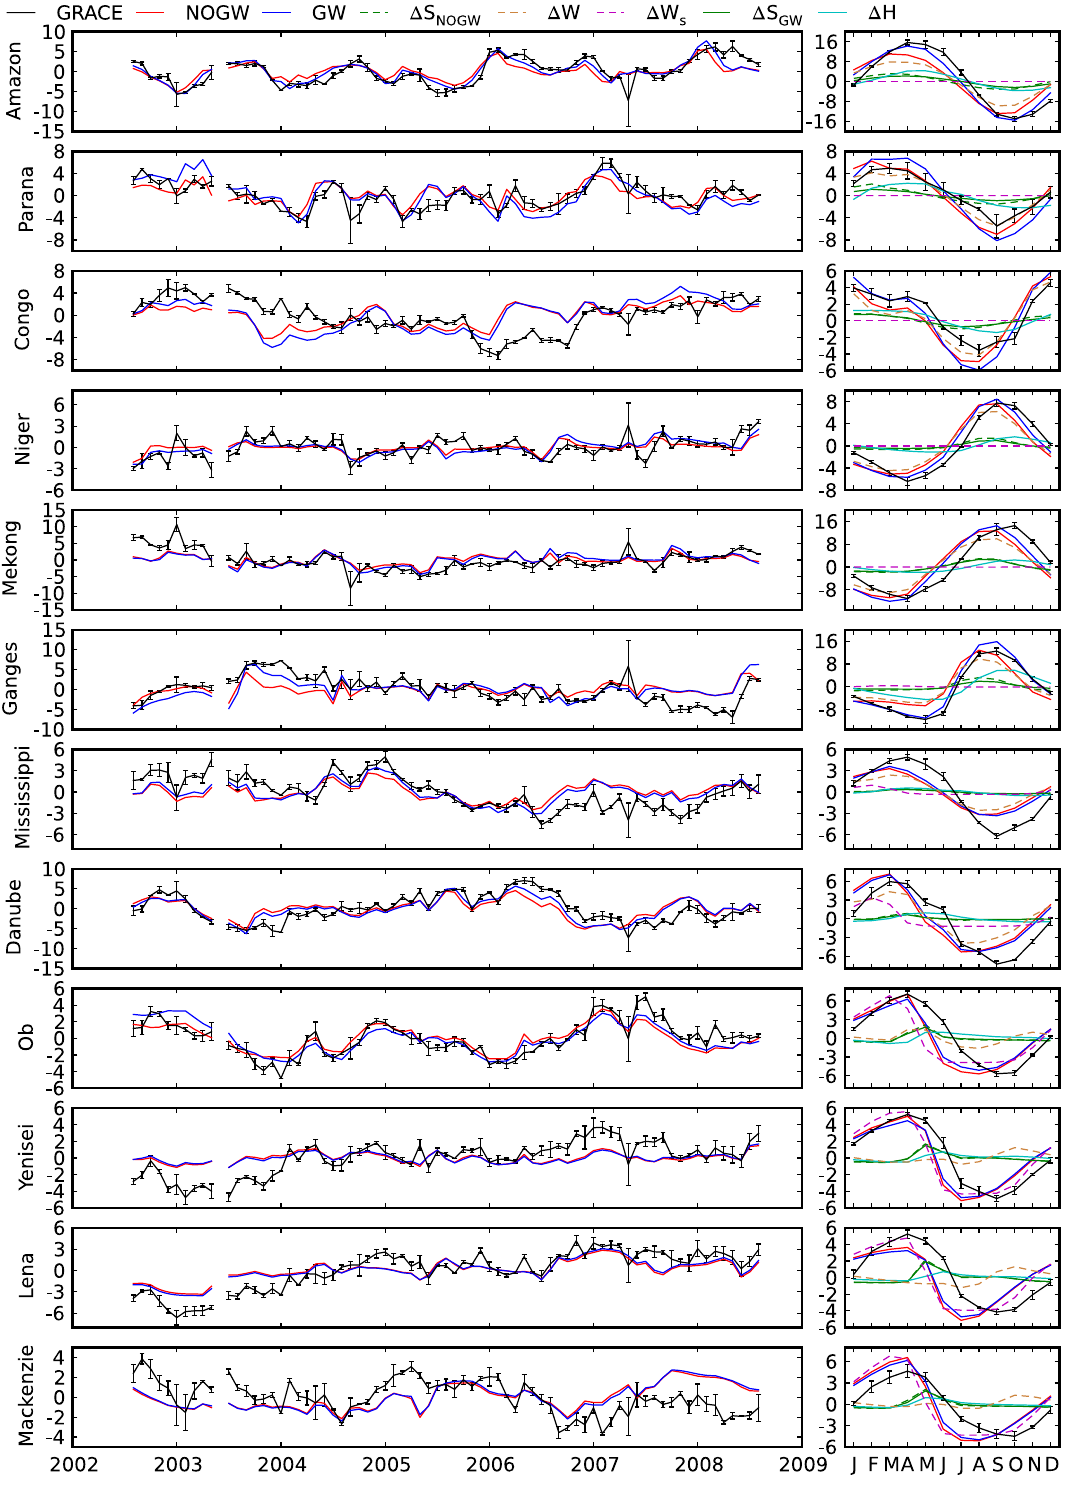
Fig. 8. Basin-scale comparison between the (right) mean annual cycle and (left) monthly anomalies of simulated NOGW (red) and GW (blue) 1 TWS, and the mean GRACE product (black) with its associated error bars. Annual cycles of each TWS component, except 1 W r , are also shown in dashed lines: 1 W (brown), 1 W s (magenta) and 1 S NOGW (green). The GW specific components 1 S GW (green) and 1 H (cyan) are plotted in solid lines. Statistics for each basin are shown in Table